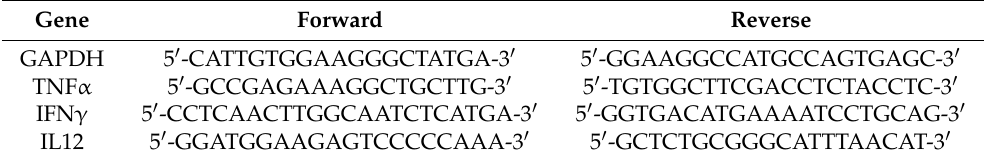
Table 1. The primers’ sequences used to evaluate gene expression.